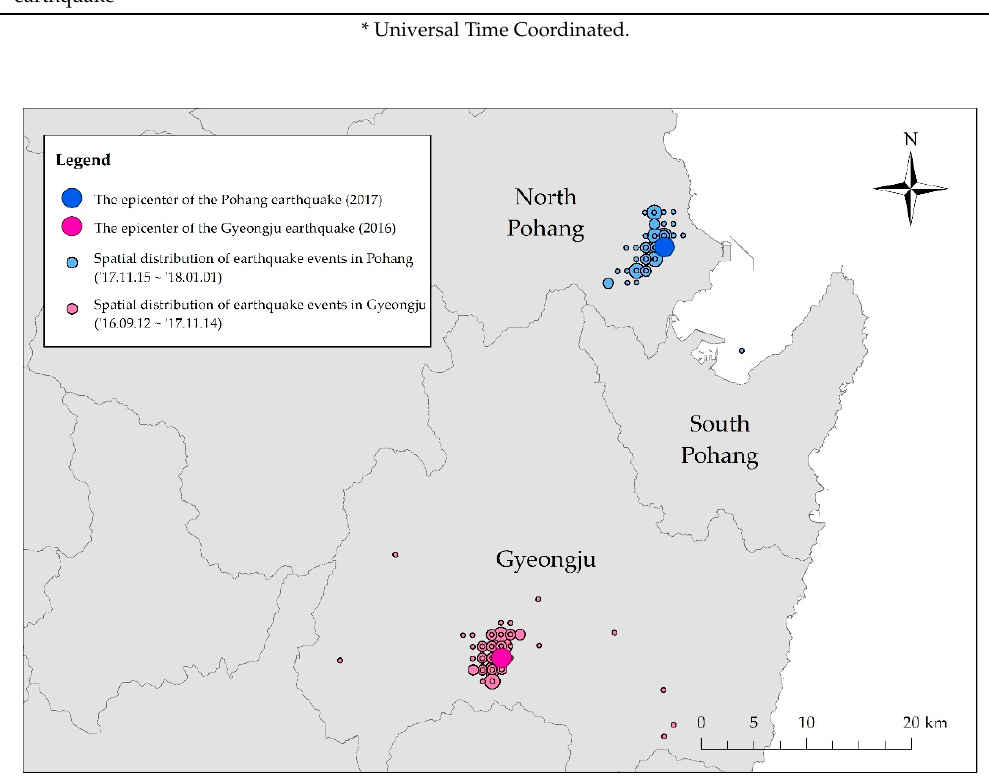
Figure 1. Location of the epicenters of the Pohang and Gyeongju earthquakes, and the spatial distribution of seismic events near the epicenters.